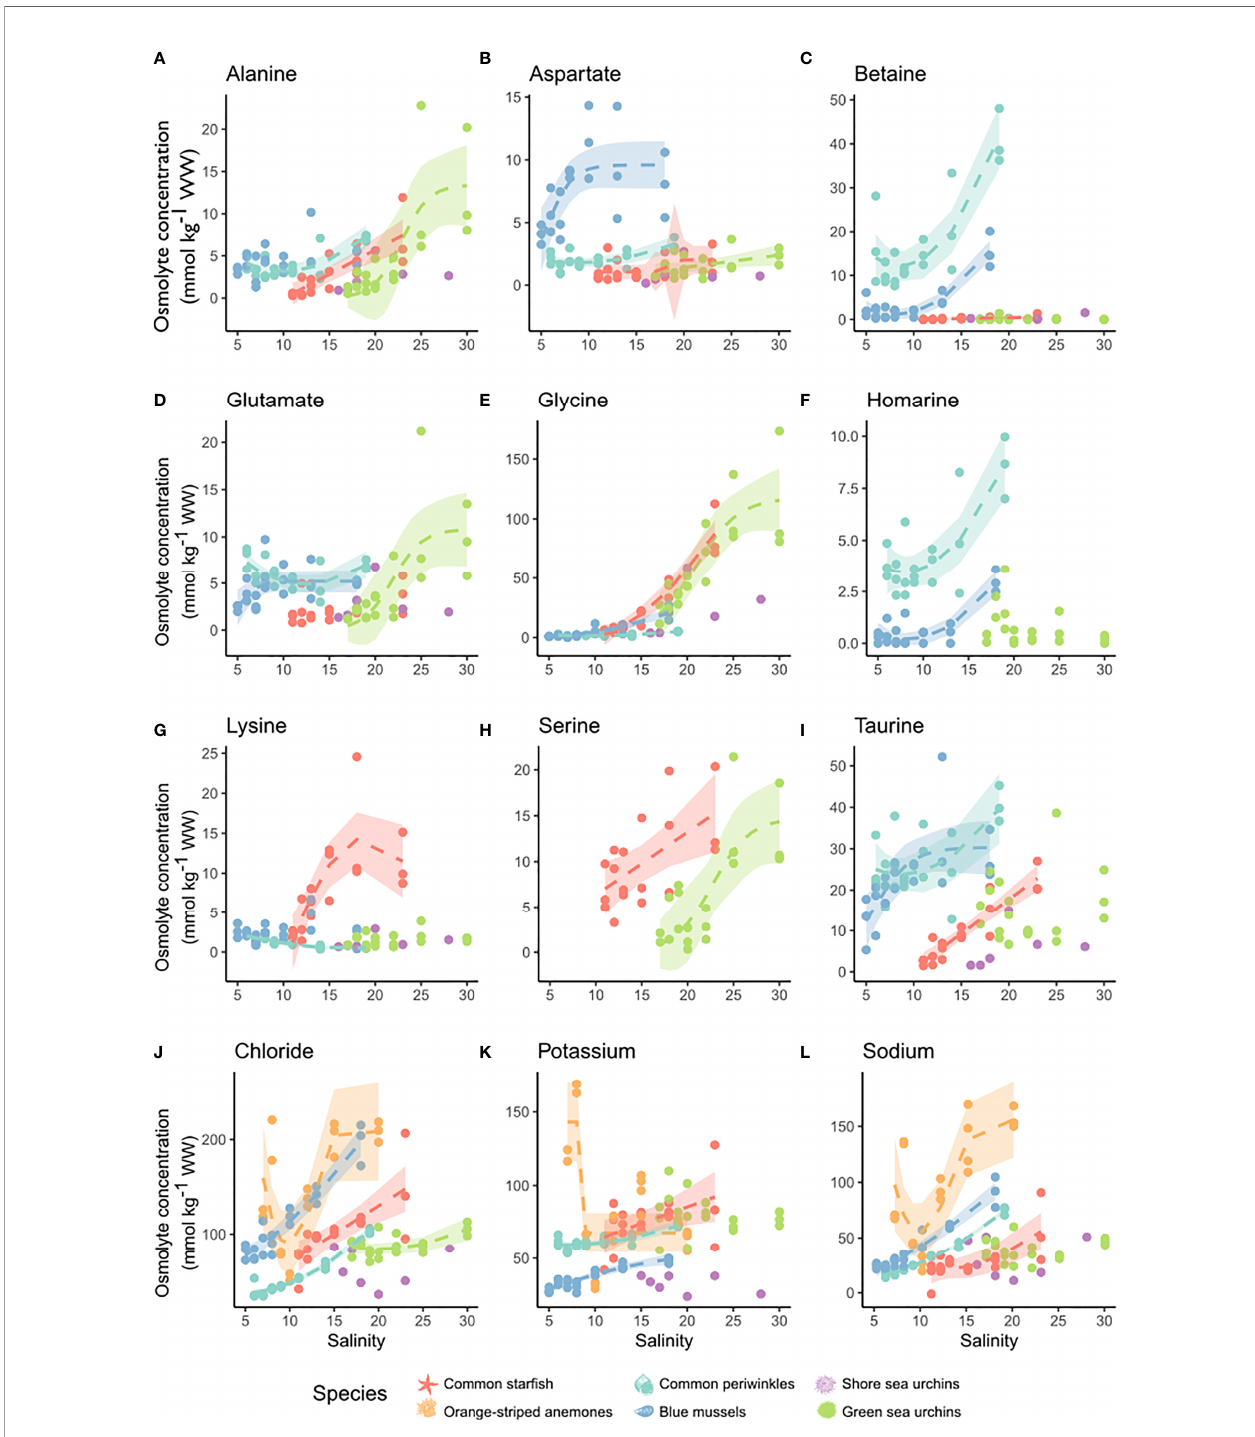
FIGURE 6 | Salinity effect of the major inorganic and organic osmolytes. Depicted are the main osmolytes in tissues of the six study organisms: blue mussels (blue, Mytilus sp.,) common periwinkles (turquoise, L. littorea ), orange-striped anemones (orange, D. lineata ), shore sea urchins (purple, P. milliaris ), green sea urchins (green, S. droebachiensis ) and common star fi sh (red, A. rubens ). Osmolyte concentrations were corrected for relative weight changes due to an increase in water content with decrease in salinity. Concentration of the respective osmolyte is shown on the y-axis (mmol kg -1 WW) and salinity is depicted on the x-axis. The following osmolytes are shown: (A) alanine, (B) aspartate, (C) betaine, (D) glutamate, (E) glycine, (F) homarine, (G) lysine, (H) serine, (I) taurine, (J) chloride, (K) potassium and (L) sodium. Models were chosen according to best fi t and their predicted values are depicted by lines. Only signi fi cant models were shown. If no data is shown for certain species that means that this substance was not detected. If only data points are shown without a model, that means that there was no signi fi cant model. Con fi dence intervals (95%) are shown as shaded area. No organic osmolytes were measured for orange-striped anemones. For model results see Table S5